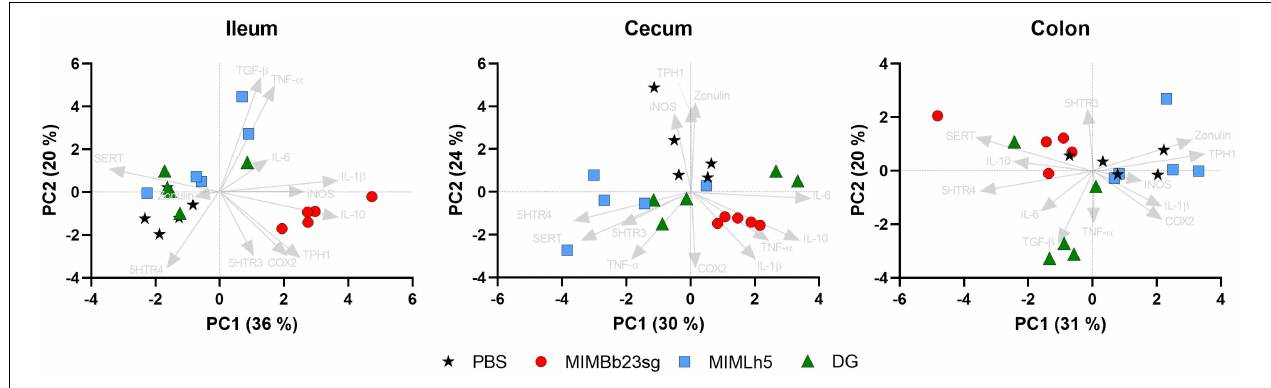
FIGURE 5 | Bi-plot of the principal components analysis (PCA) showing the loading of gene expression data (arrows) and the scores of each mouse (symbols).